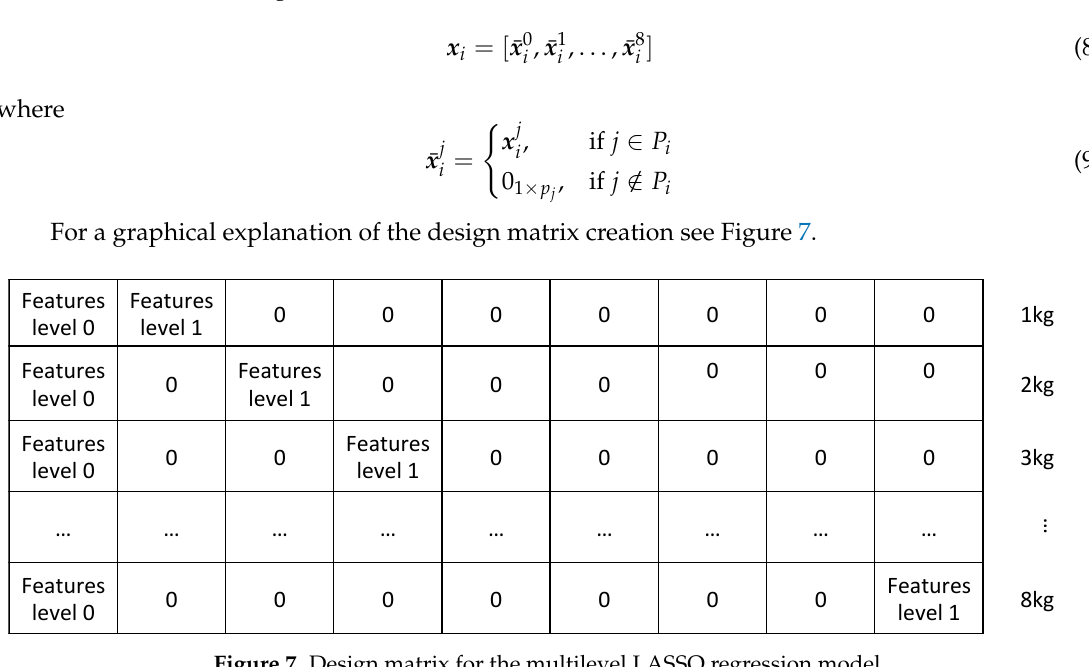
Figure 7. Design matrix for the multilevel LASSO regression